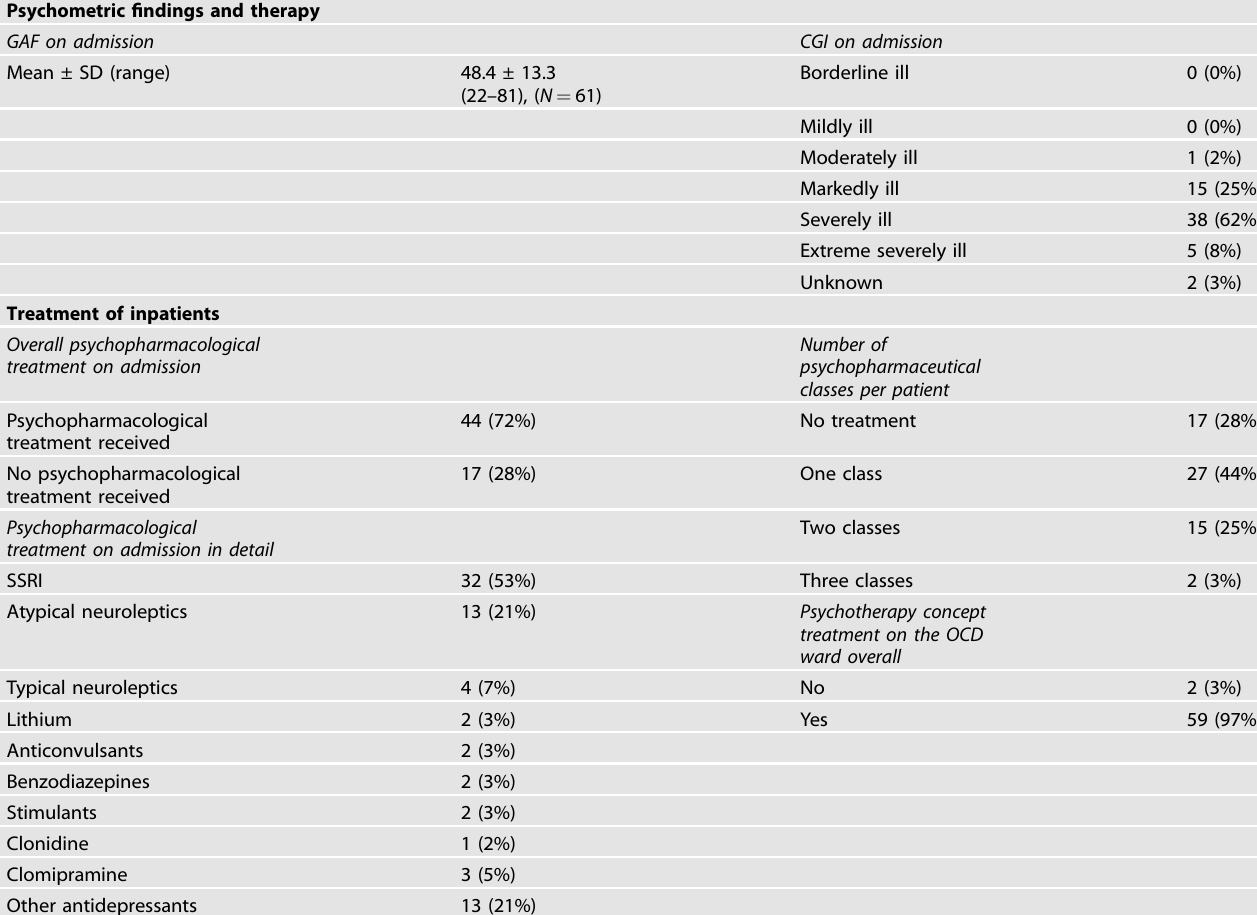
Table 2. Psychometric fi ndings and